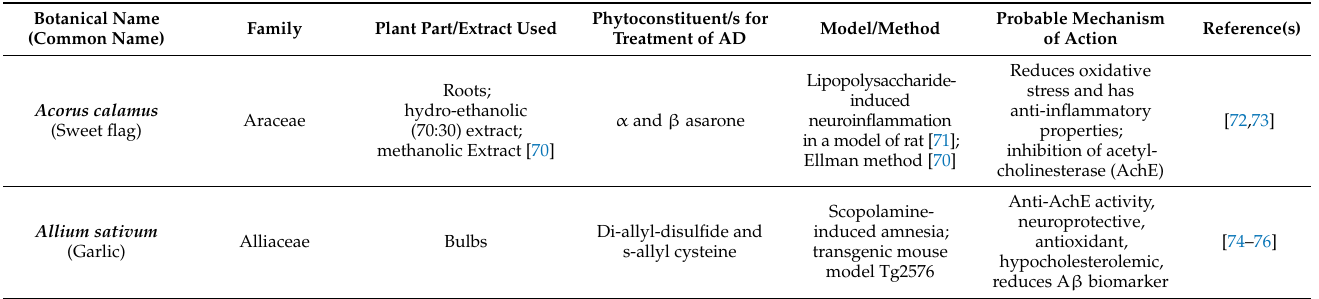
Table 2. Various herbs with their family, plant extract, phytoconstituents, and probable mechanism of action for the treatment of